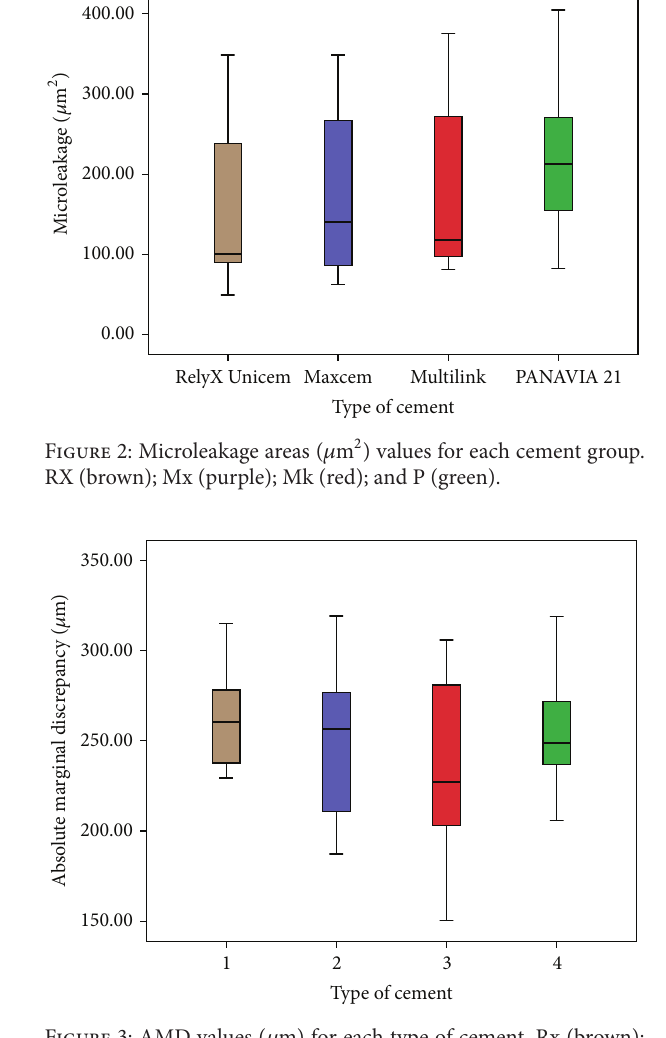
Figure 3: AMD values ( 𝜇 m) for each type of cement. Rx (brown); Mx (purple); Mk (red); and P